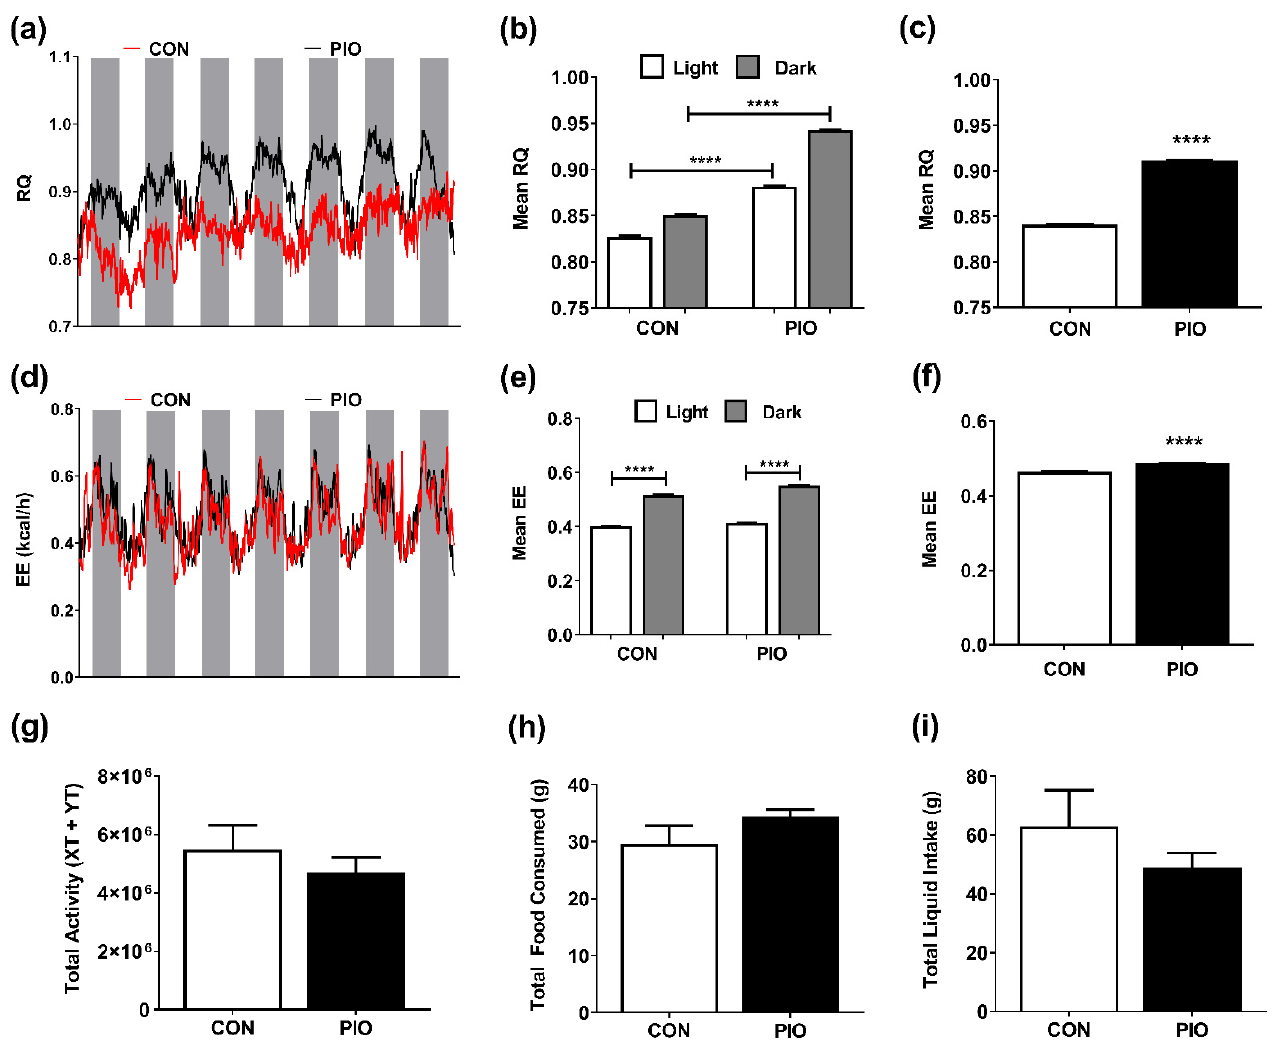
Figure 3. Pioglitazone increases respiratory quotient (RQ) and energy expenditure (EE), but does not impact activity or caloric intake. ( a ) RQ at daily intervals showing light (daytime; white bars) and dark (night time; grey bars) cycles, ( b ) mean RQ across light cycles, ( c ) mean RQ across all time points, ( d ) EE at daily intervals showing light (day) and dark (night) cycles, ( e ) mean EE across light cycles, ( f ) mean EE across all time points, ( g ) total activity, ( h ) total food consumed, ( i ) total liquid consumed in db/db mice on either a CON or PIO-supplemented diet for 7 d. n = 8 per group. Data are represented as the means ± SEM. **** p < 0.0001.